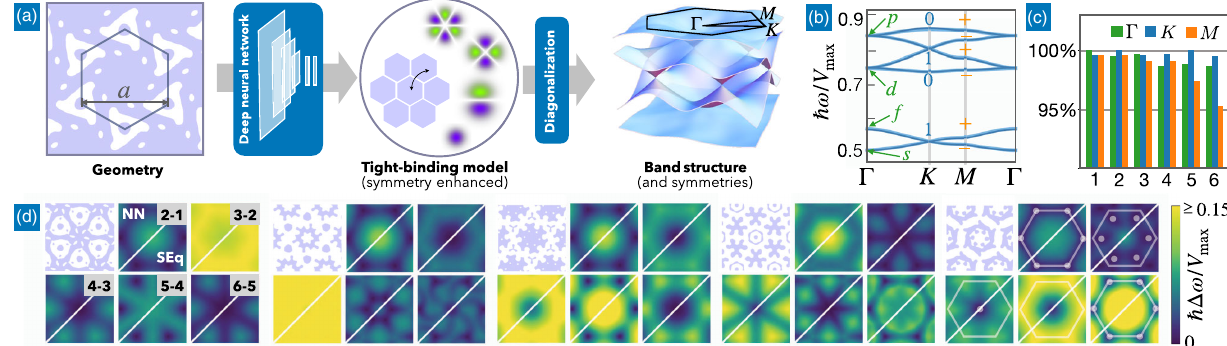
FIG. 1. Neural-network-based prediction of band structures from unit-cell geometries or potentials. (a) The geometry is fed into a multilayer convolutional network (Appendix A) producing the coefficients of a symmetry-enhanced tight-binding model, which is then diagonalized to obtain the band structure. (b) Cut along the k path indicated in (a), for the same band structure (now including also the first two bands), comparing the Schrödinger equation (dark thin lines) and NN (thick light lines). The two types of predictions are difficult to distinguish with the bare eye. The symmetry labels are also indicated ( 0 = 1 indicate the quasiangular momentum; þ and − label the even and odd states, respectively). (c) Fraction of correctly predicted symmetry labels at each high-symmetry point ( Γ , K , and M ) and for each band on validation geometries unknown to the NN. (d) Comparing the k -resolved band gap ω validation geometries (NN vs Schrödinger). For the last potential, the band-gap zeros are marked by white dots. The crossings of the second and third band define a sextuplet of Dirac cones that are not pinned to any high-symmetry point. In all plots, the height of the 16 ℏ Þ 2 = ð 2 ma 2 Þ potential is V max ¼ ð